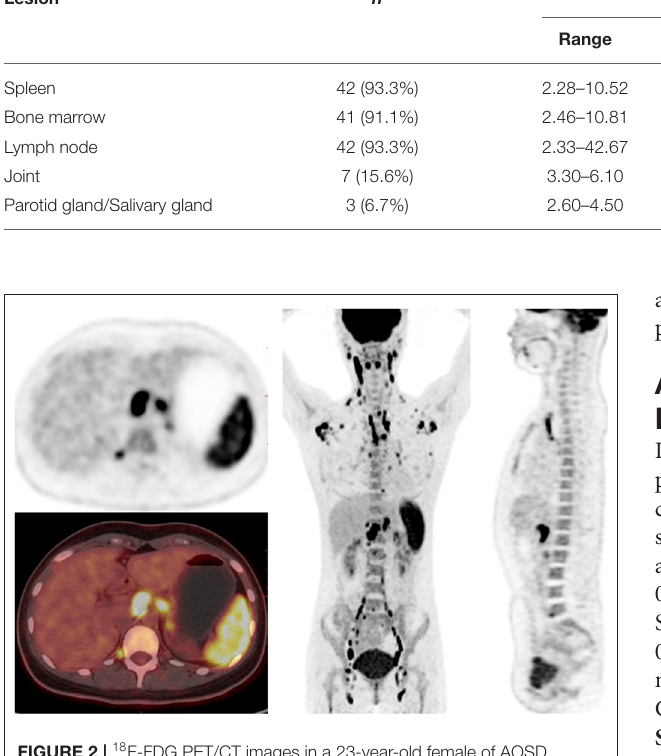
FIGURE 2 | 18 F-FDG PET/CT images in a 23-year-old female of AOSD patient. PET/CT showed diffusely increased 18 F-FDG uptake in spleen, bone marrow and lymph nodes, and reactive hyperplastic lymph nodes symmetrically distributed in the whole